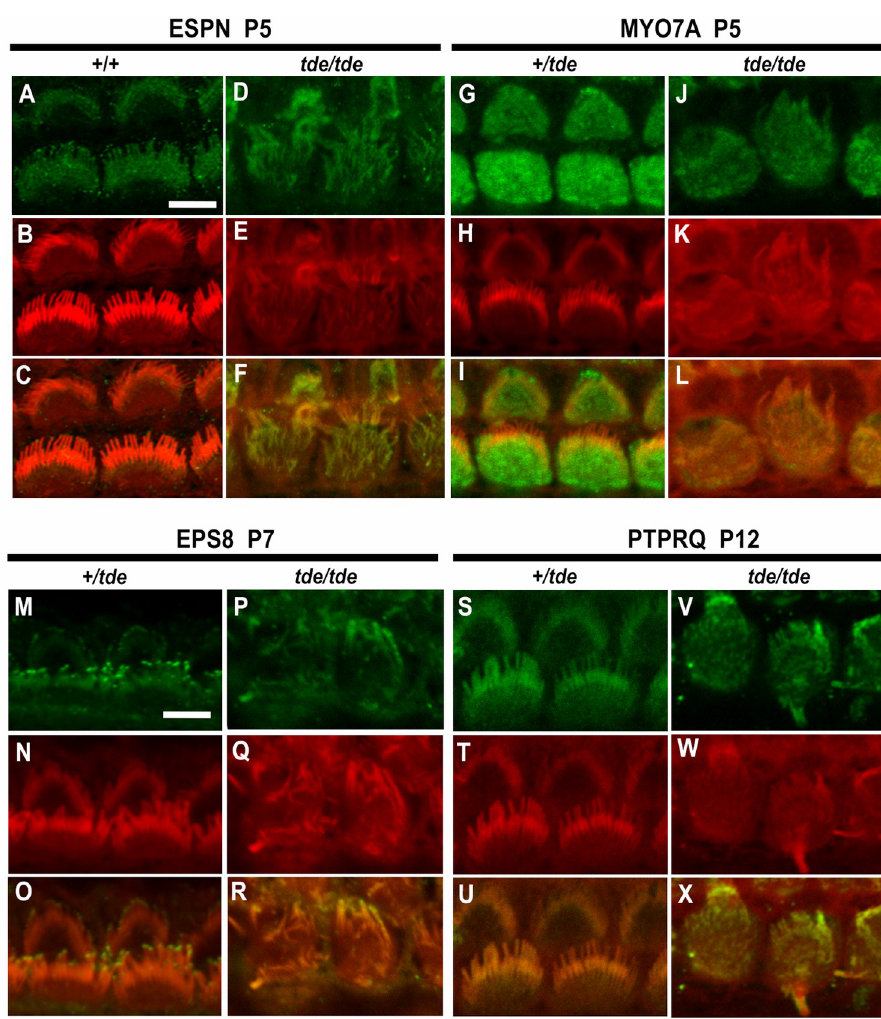
Fig 4. Analysis of hair bundle protein expression by immunofluorescence. Inner ear tissue from +/ tde and tde / tde at P5-P12 were incubated with antibodies for hair bundle proteins ESPN, MYO7A, EPS8 and PTPRQ (in green), rhodamine-phalloidin (in red) and merged images (yellow) obtained by confocal microscopy. Images show inner hair cell (IHC) staining in the middle turn of the cochlear duct. A-F , ESPN is expressed in a punctate manner along the length of stereocilia in controls and tde mutants (P5, +/+ and +/ tde n = 3, tde/tde n = 6 mice). G-L , MYO7A is expressed widely within the top of the hair cell of tde mutants in a broadly similar way to heterozygotes (P5, +/ tde n = 4, tde/tde n = 3 mice). M-R , EPS8 immunoreactivity is detected at the tips of stereocilia in heterozygous mice and also in the tips of the thinner and more disorganized stereocilia of tde mutants (P7, +/ tde n = 5, tde/tde n = 4 mice). S-X , PTPRQ expression is found throughout the length of stereocilia in heterozygous mice and a broadly similar distribution is also observed in tde mutants (P12, +/ tde n = 4, tde/tde n = 1 mice). Scale bars: 5 μ m.